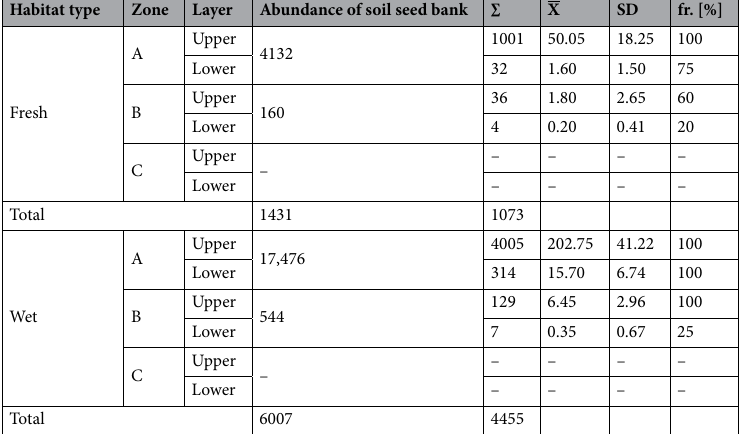
(Fig. 3). Of the native species, only single seedlings of U. dioica, Stellaria graminea and Chenopodium polysper- mum started growing in the first week of the experiment. However, the highest number of seedlings of the native plants appeared in the II–V months of the experiment and after removal of the Rudbeckia seedlings. The relationship between soil seed bank and vegetation cover. The highest similarity between the vegetation cover and soil seed bank was observed in the control zone in the wet meadow (Sorensen index was 0.6) and the smallest in the invasion zones in both habitats, as well as in the control zone in the fresh meadow (0.4). The similarity coefficient in the transition zones was 0.5 for both types of habitats (Supplementary Infor- mation S3). The highest participation of taxa occurring only in the seed bank was observed in the invasion zone (47% in the fresh, 56% in the wet meadow). In other zones, it did not exceed 25%. In the transition zone in both habitat types, the share of taxa common for the two habitat types and the ones occurring only in the vegetation cover increased in comparison to the invasion zone. The control zone in the fresh meadow had the highest share of taxa